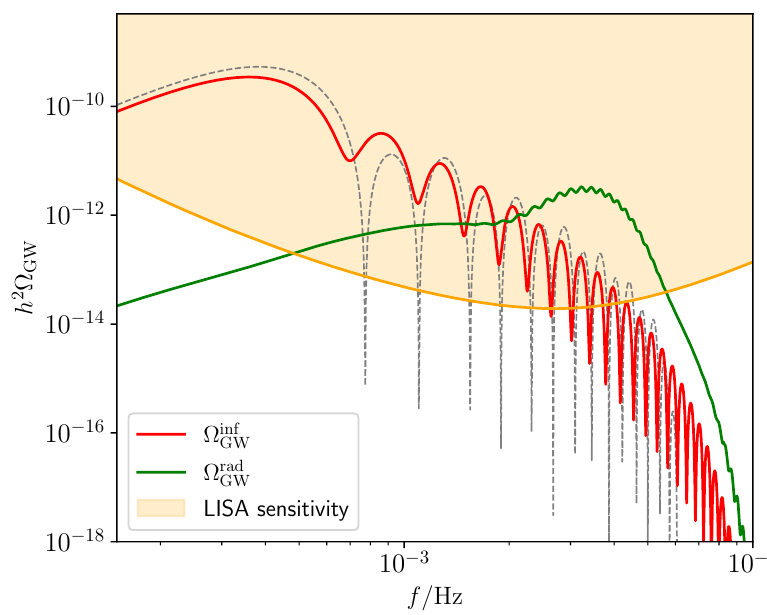
Figure 1 . In red, the characteristic inflationary gravitational wave energy density from the emer- gence of an excited state during inflation. This spectrum is the subject of the current work where it is computed explicitly. In green, the scalar induced post-inflationary gravitational wave spectrum resulting from the presence of the same excited state triggered by a sharp feature during inflation. The shape of this contribution has been computed in [21]. The grey dashed line represents the analytical template computed in section 4, and explicitly given in eq. (6.1), which is independent of the specific model generating the excited